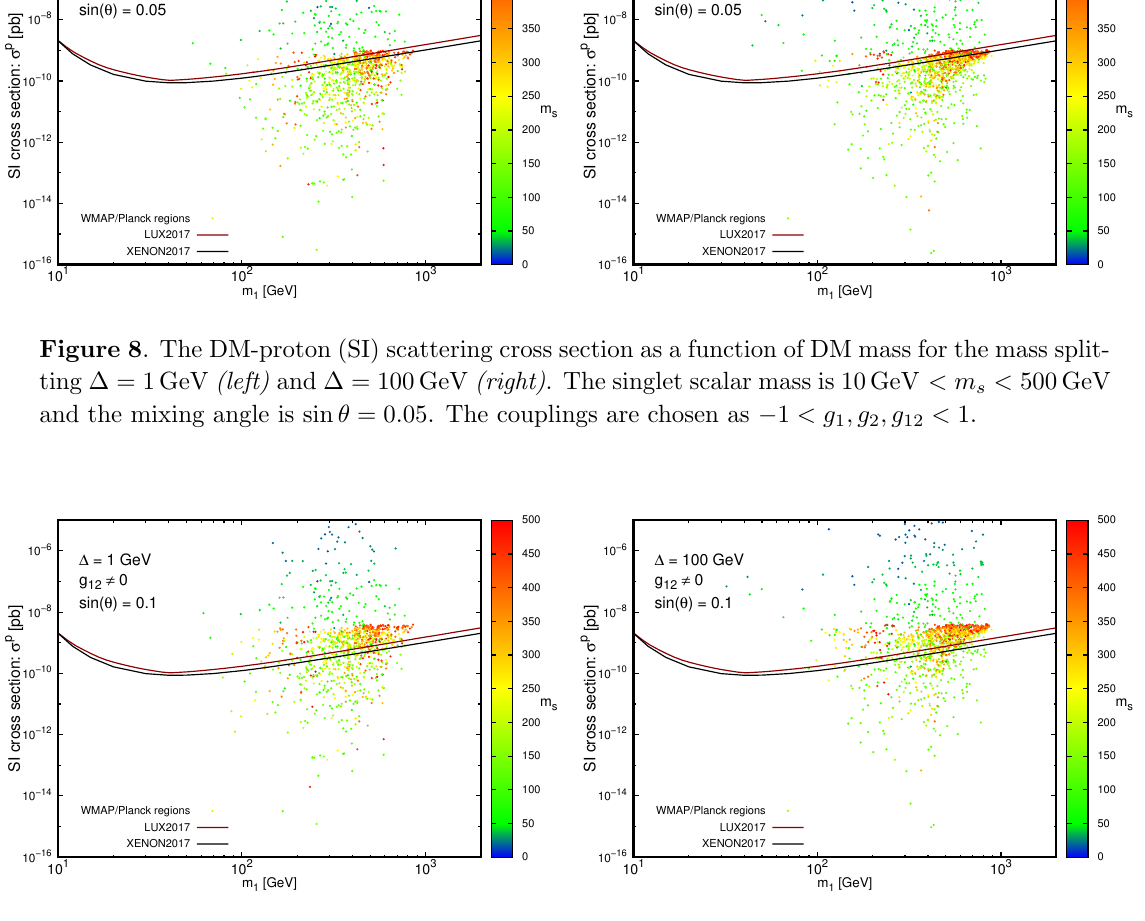
the case with (cid:1) = 1 GeV. At larger mass splitting that the coannihilation e(cid:11)ects are